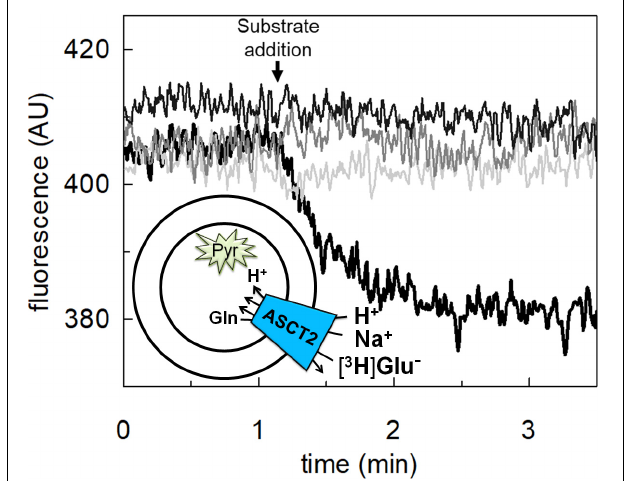
FIGURE 8 | Transport of proton by hASCT2 reconstituted in proteoliposomes. Purified hASCT2 was reconstituted in proteoliposomes containing 10 mM glutamine and 0.1 mM pyranine as described in materials and methods. The fluorescence measurement was started by adding 150 µ L proteoliposomes to the transport buffer (up to 3 mL final volume) composed by Hepes Tris 20 mM pH 7 and 100 mM Na-gluconate. After ∼ 1 min, as indicated by the arrow, 5 mM glutamate (thick black line) or 1 mM glutamine (gray line) was added to the sample and fluorescence change was recorded. As a control, the same measurement was performed in the absence of Na-gluconate (black line); in the blank sample, 10 µ M HgCl 2 was added at time 0 to the transport buffer (light-gray line). In the figure, sketch of the experimental set up (proteoliposomes); Pyr: pyranine. The fluorescence signal is indicated as arbitrary units (AU). Results are representative of three independent